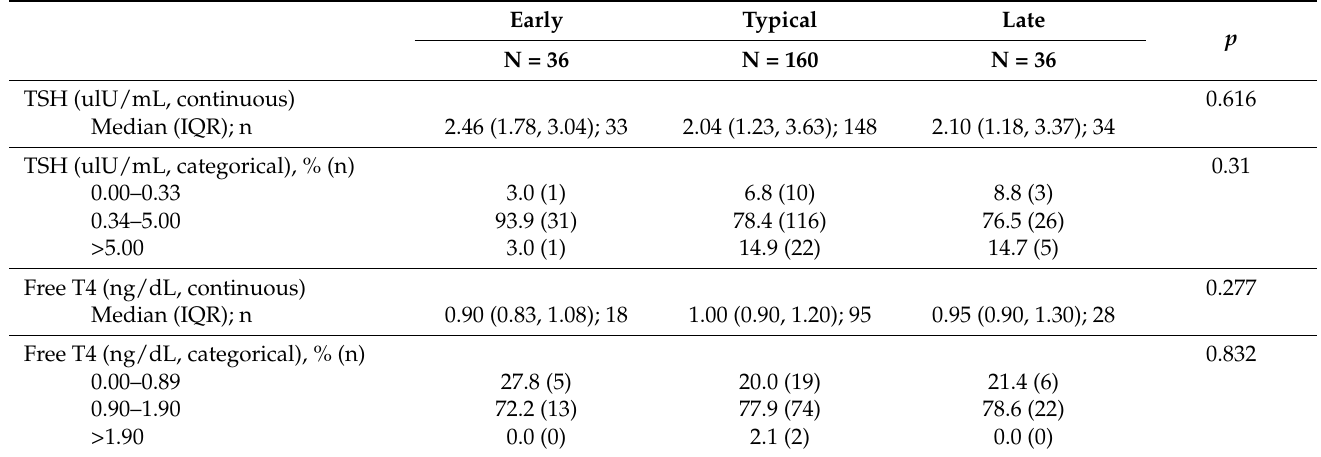
Table 2. Thyroid function tests: summaries by age of AD onset